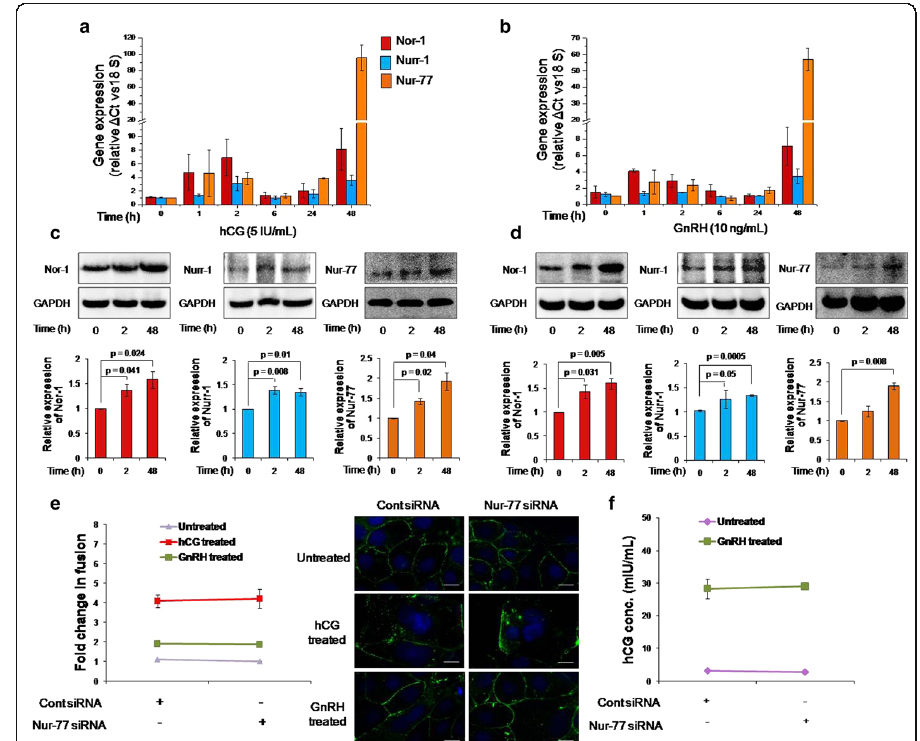
Fig. 3 Effect of Nur-77 knockdown on hCG- and GnRH-mediated cell fusion and hCG secretion. BeWo cells were treated with either hCG (5 IU/ml) or GnRH (10 ng) for various times. Subsequently, total RNA and cell lysates were isolated and processed for qRT-PCR and Western blotting, respectively, to analyze the transcript and protein levels of Nor-1, Nurr-1 and Nur-77. a and b – qRT-PCR analysis of Nor-1, Nurr-1 and Nur-77 in the form of bar graphs of BeWo cells treated with hCG and GnRH, respectively. Relative expression was normalized with 18S rRNA. Data are expressed as means ± s.e.m. of three independent experiments performed in triplicate. c and d – Protein expression profiles of Nor-1, Nurr-1 and Nur-77 in BeWo cells after treatment with hCG and GnRH, respectively, with GAPDH used as an internal control. Values are expressed as means ± s.e.m. of the band intensity of three independent experiments. Representative blots for the same experiment are appended with the graphs. BeWo cells transfected with either Nur-77 siRNA or control siRNA were treated with either hCG (5 IU/ml) or GnRH (10 ng/ml). The fold change in fusion was estimated after 48 h using desmoplakin I + II staining and hCG secretion was analyzed in GnRH treated cells via ELISA. e – The effect of hCG and GnRH treatment in the control and Nur-77-silenced BeWo cells on fusion at 48 h. The data are expressed as means ± s.e.m. of three independent experiments. Representative images of desmoplakin I + II staining in green and DAPI in blue are appended alongside. The scale bar is 20 μ m. f – hCG secreted by control and Nur-77-silenced BeWo cells in response to GnRH treatment at 48 h. Data are represented as means ± s.e.m. of three independent experiments performed in duplicate. p ≤ 0.05 is considered statistically